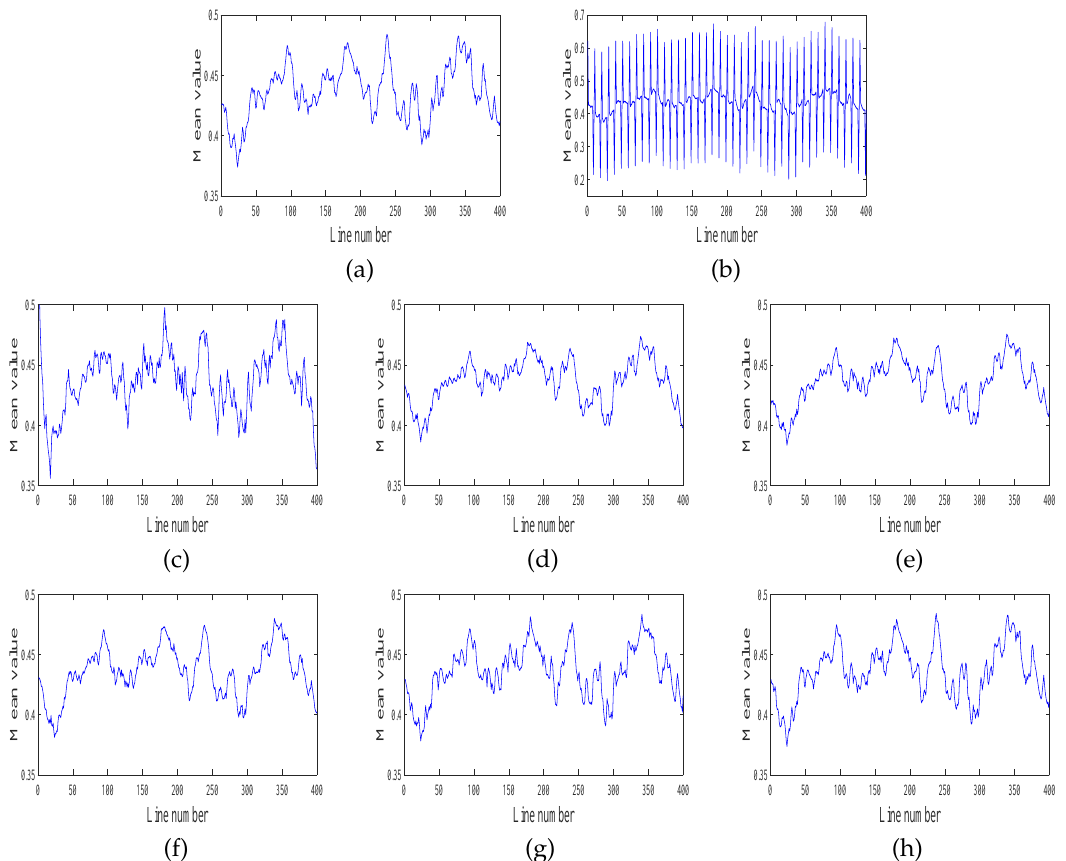
Figure 9. Spatial mean cross-track profiles for simulated image of the first simulated example of Figure 3: ( a ) underlying image; ( b ) degraded image; and destriping results by: ( c ) WFAF; ( d ) SLD; ( e ) UTV; ( f ) GSLV; ( g ) LRSID; and ( h )